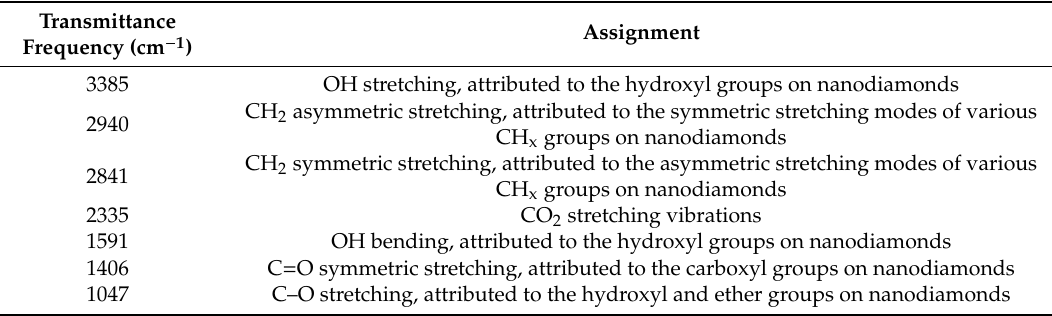
Figure 3. ( a ) Fourier transform infrared spectroscopy (FTIR) spectrum of the as-received fluorescent nanodiamond (inset of the figure represents the spectral region from 2300–3800 cm − 1 showing OH and CH groups). ( b ) Schematic showing several functional groups that exist on the surface of the as-received nanodiamond. Table 1. FTIR peak assignments from as-received nanodiamond.